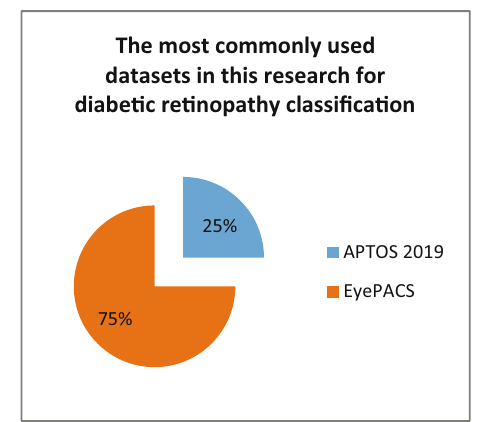
Figure 13: Most commonly used datasets in this research for diabetic retinopathy classi fi cation.